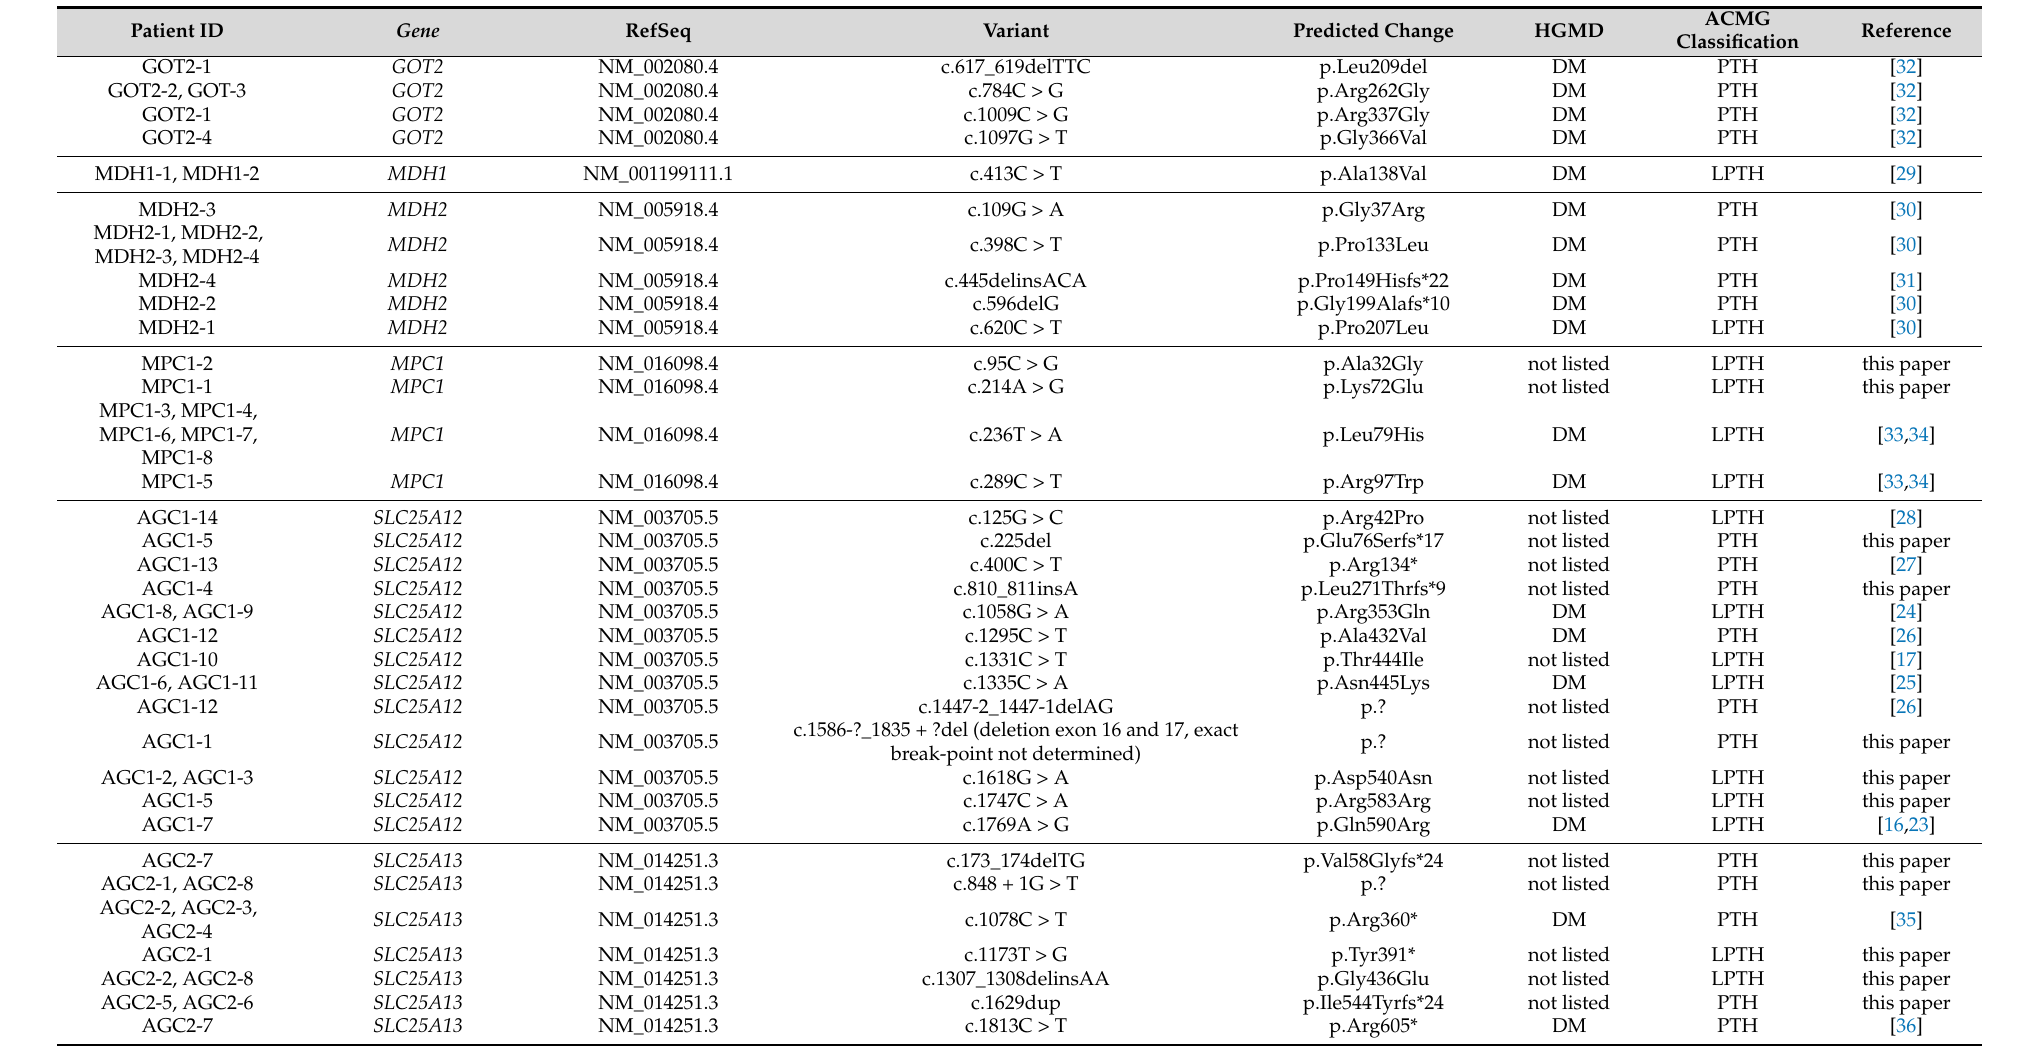
Table 3. Genotype of all individuals